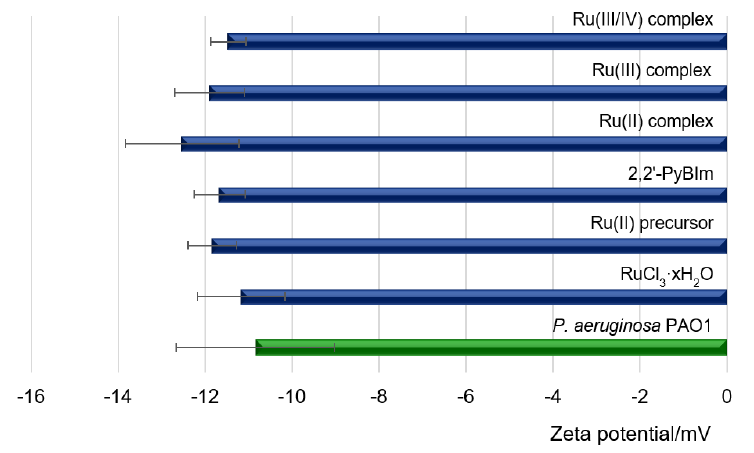
Figure 6. Zeta potentials of P. aeruginosa PAO1 with original surface and with the addition of the Ru complexes.